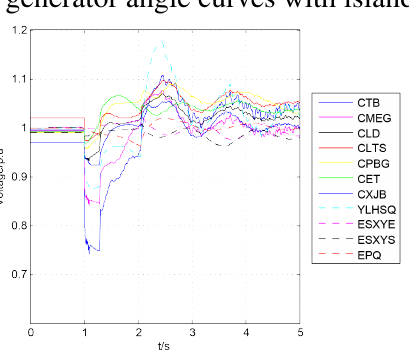
a: The generator angle curves without islanding. d: The generator angle curves with islanding.